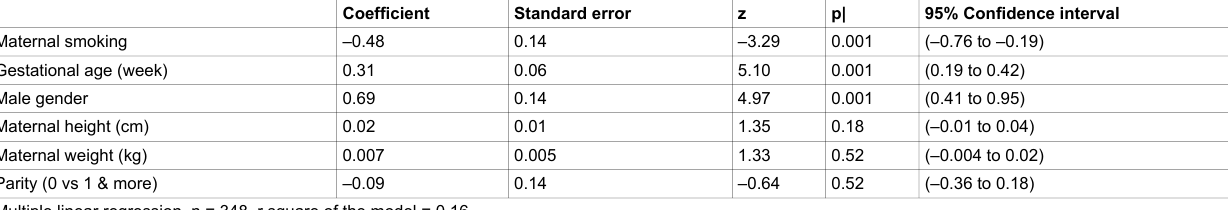
Table Vb: The impact of maternal smoking on the head circumference of term